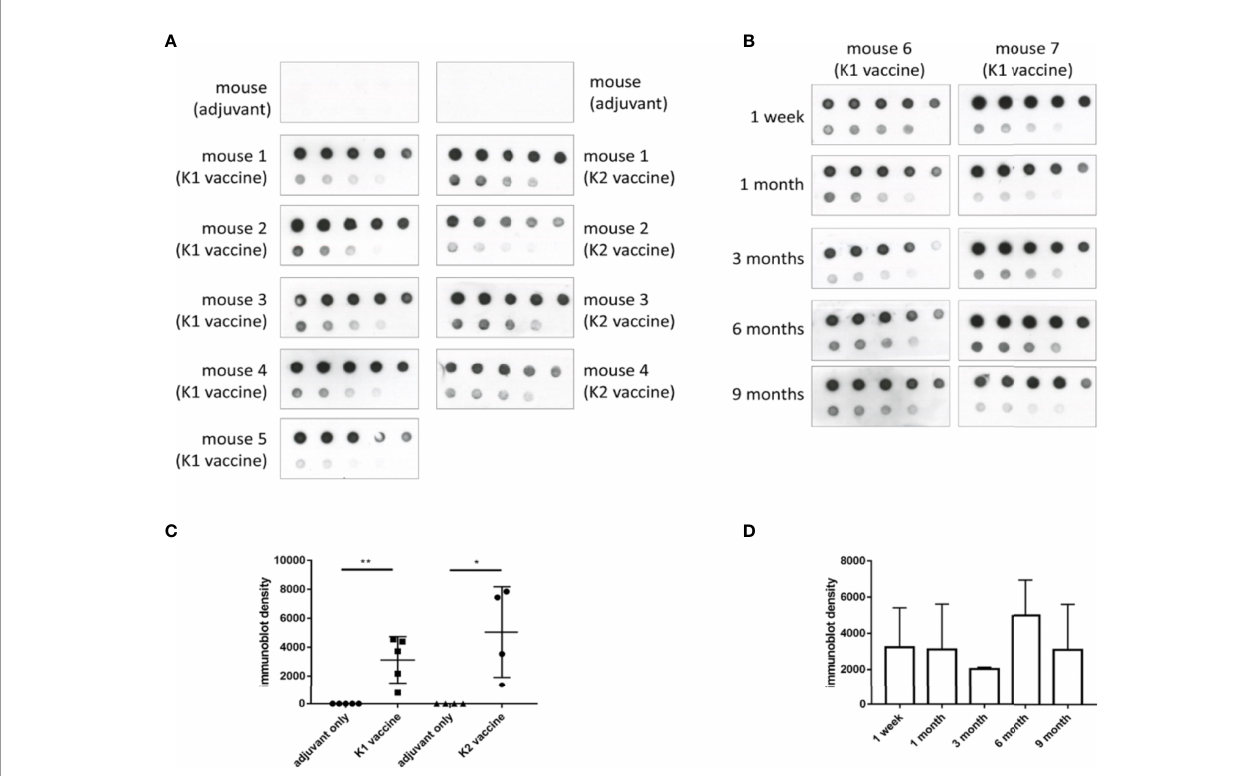
FIGURE 4 | The induction and persistence of antibodies against CPS in mice administered with K1 or K2 CPS-conjugated vaccines. Puri fi ed K1 or K2 CPS was subjected to a serial two-fold dilution, and various amounts (2000 ng to 7.8125 ng, from the upper left to the lower right) were spotted to membranes. Membranes were then blotted with sera (1:1000 dilution) from mice that had been administered with adjuvant or K1 or K2 CPS-conjugated vaccine. (A) Dot blotting of sera collected one week after the 3rd vaccine injection. (B) Dot blotting of sera collected from either of the two K1 vaccinated mice at various intervals (1 week to 9 months) after the 3rd anti-K1 vaccine injection. (C) The density of dots spotted with 31.25 ng of CPS in (A) was quanti fi ed by using ImageJ software (Version 1.53k, USA). The antibodies against K1 or K2 CPS in mice administered with K1 or K2 CPS-conjugated vaccines were signi fi cantly higher than those received adjuvant only. The data were analyzed using the two-tailed unpaired t test. * P < 0.05; ** P < 0.01. (D) The density of dots spotted with 31.25 ng of CPS in (B) was quanti fi ed by using ImageJ software. The antibodies against K1 CPS in mice administered with K1 CPS-conjugated vaccine at various intervals (1 week to 9 months) after the 3rd anti-K1 vaccine injection were not signi fi cantly different. The data were analyzed using the Tukey ’ s multiple comparison post hoc one-way ANOVA